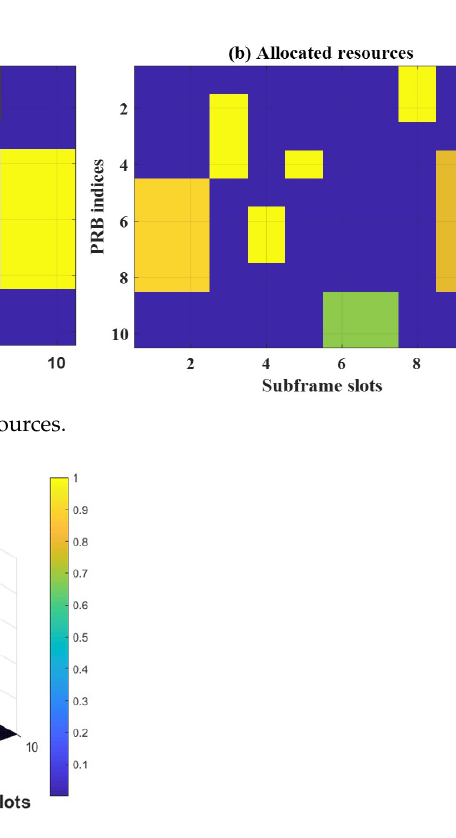
Figure 10. Wireless resource index